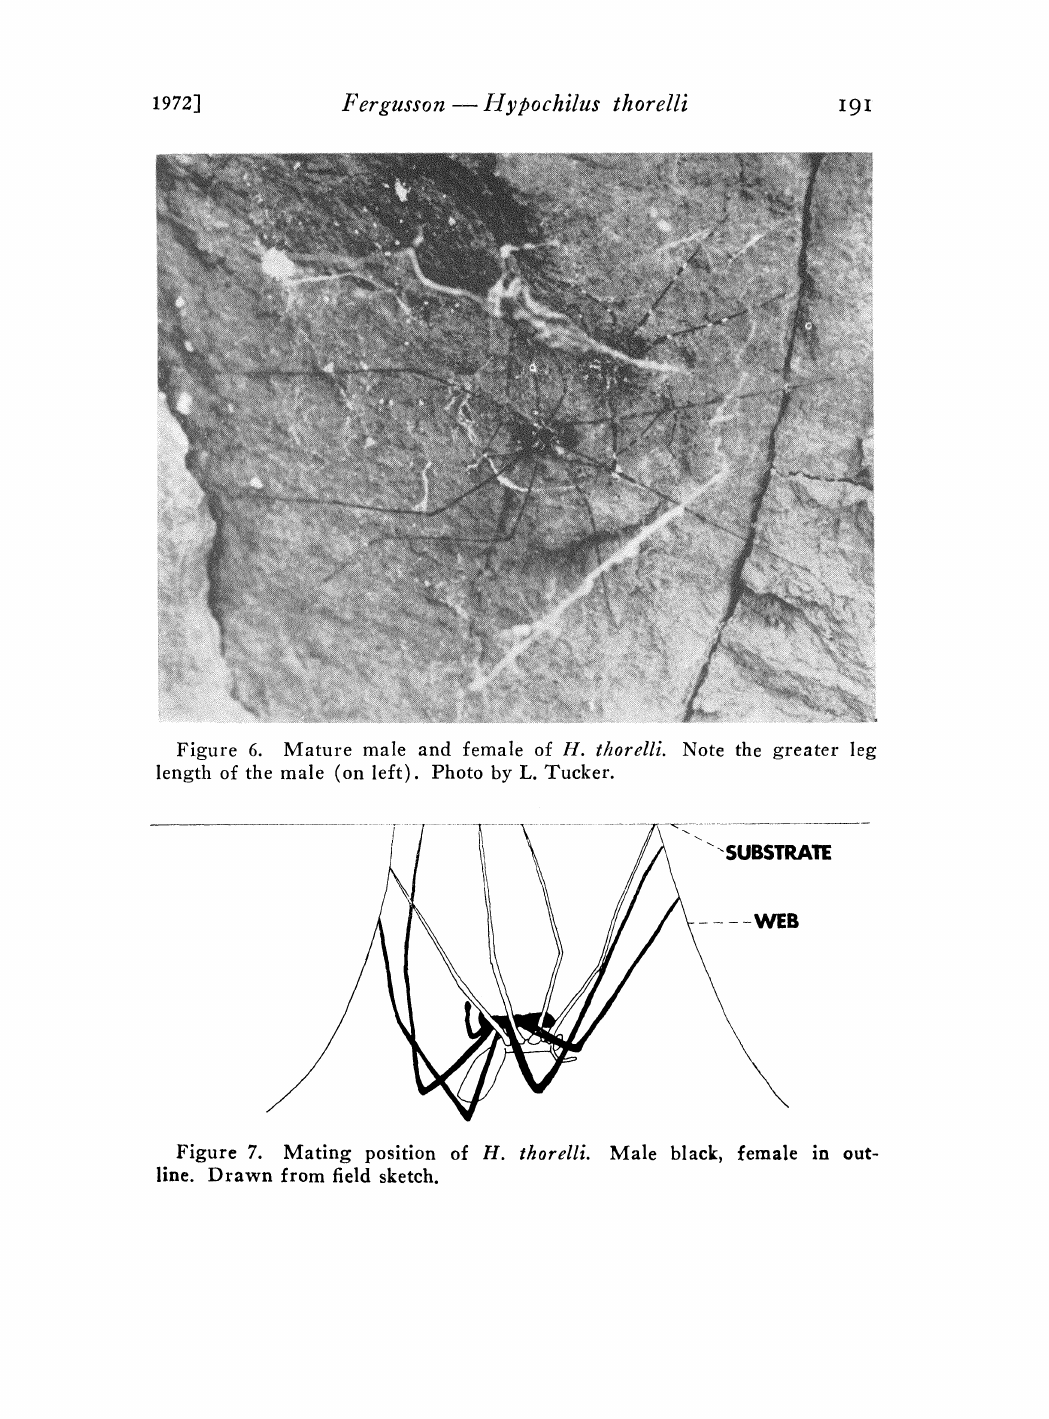
Figure 7. Mating position of H. thorelli. Male black, female in out- line. Drawn from field